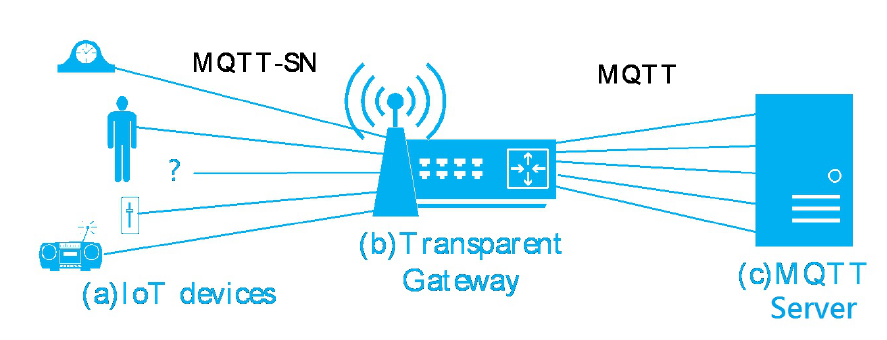
Figure 2. MQTT-SN architecture.